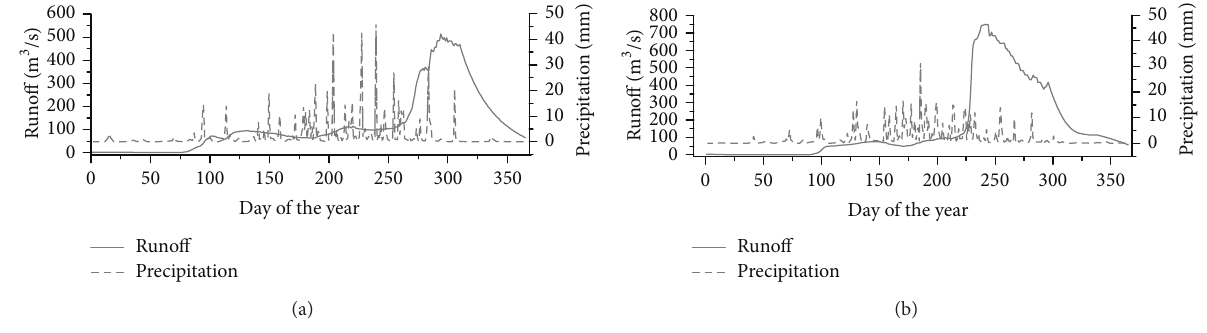
Figure 6: Daily rainfall and runoff in Caizuizi Station (a) 1959, (b)